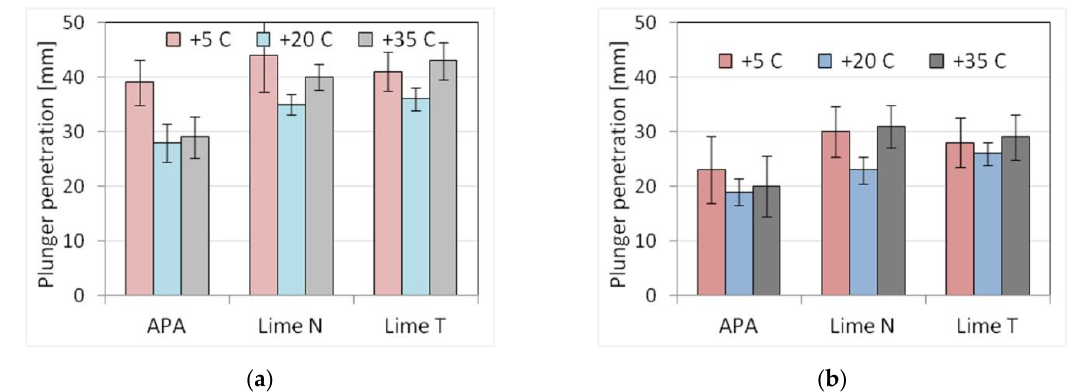
Figure 15. Influence of the temperature changes on the consistency tested by plunger penetration method of ( a ) plaster, ( b ) masonry mortars.